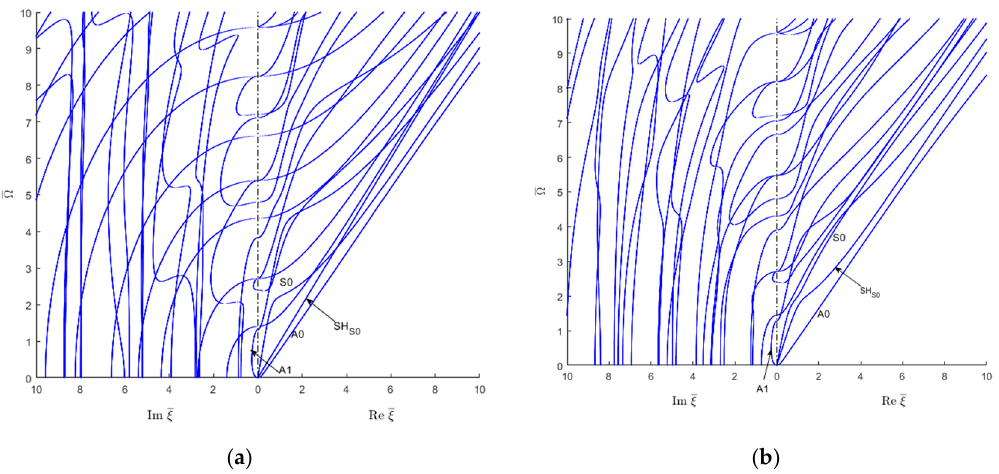
Figure 22. Complex wavenumber trajectories for 1-mm laminated CFRP composite plates: ( a ) 8-layer cross ply [0/90/0/90] S ; ( b ) 8-layer quasi-isotropic [0/+45/ − 45/90] S.